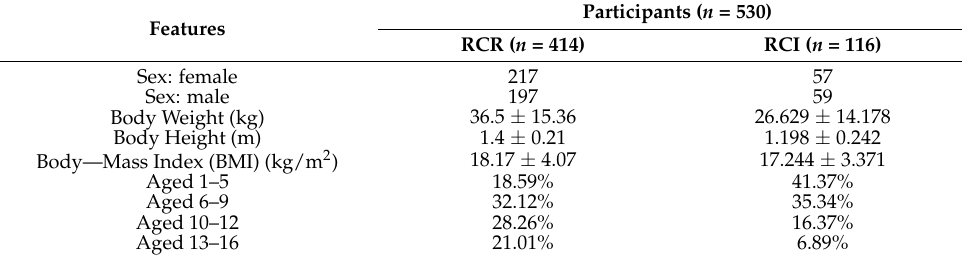
Figure 2. Comparison between physical activities of children. Figure 3. Comparison between preferred types of seasonings.